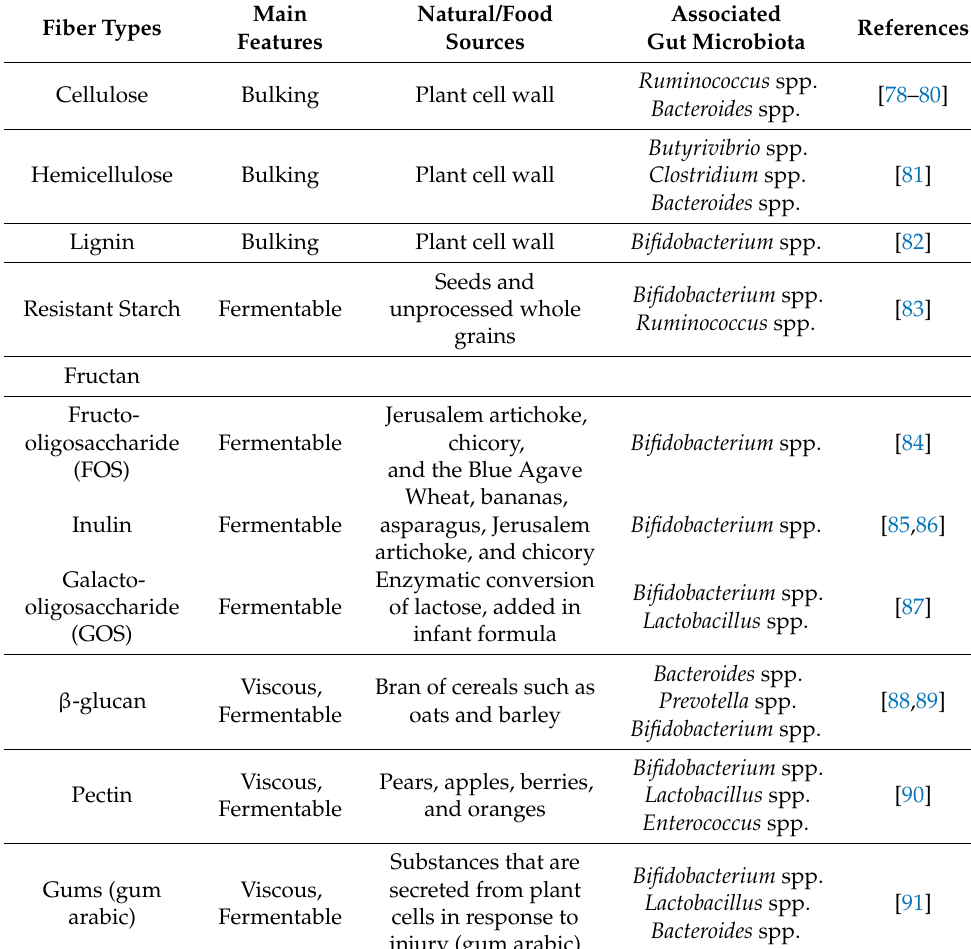
Table 1. Types of dietary fibers associated with the growth of certain gut